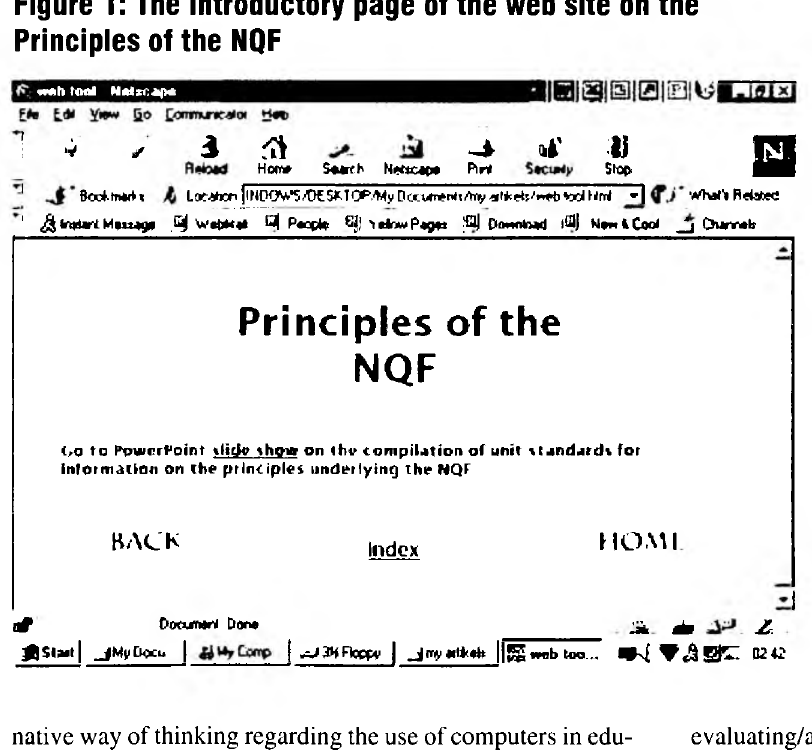
Figure 1 : The introductory page of the web site on the Principles of the NQF